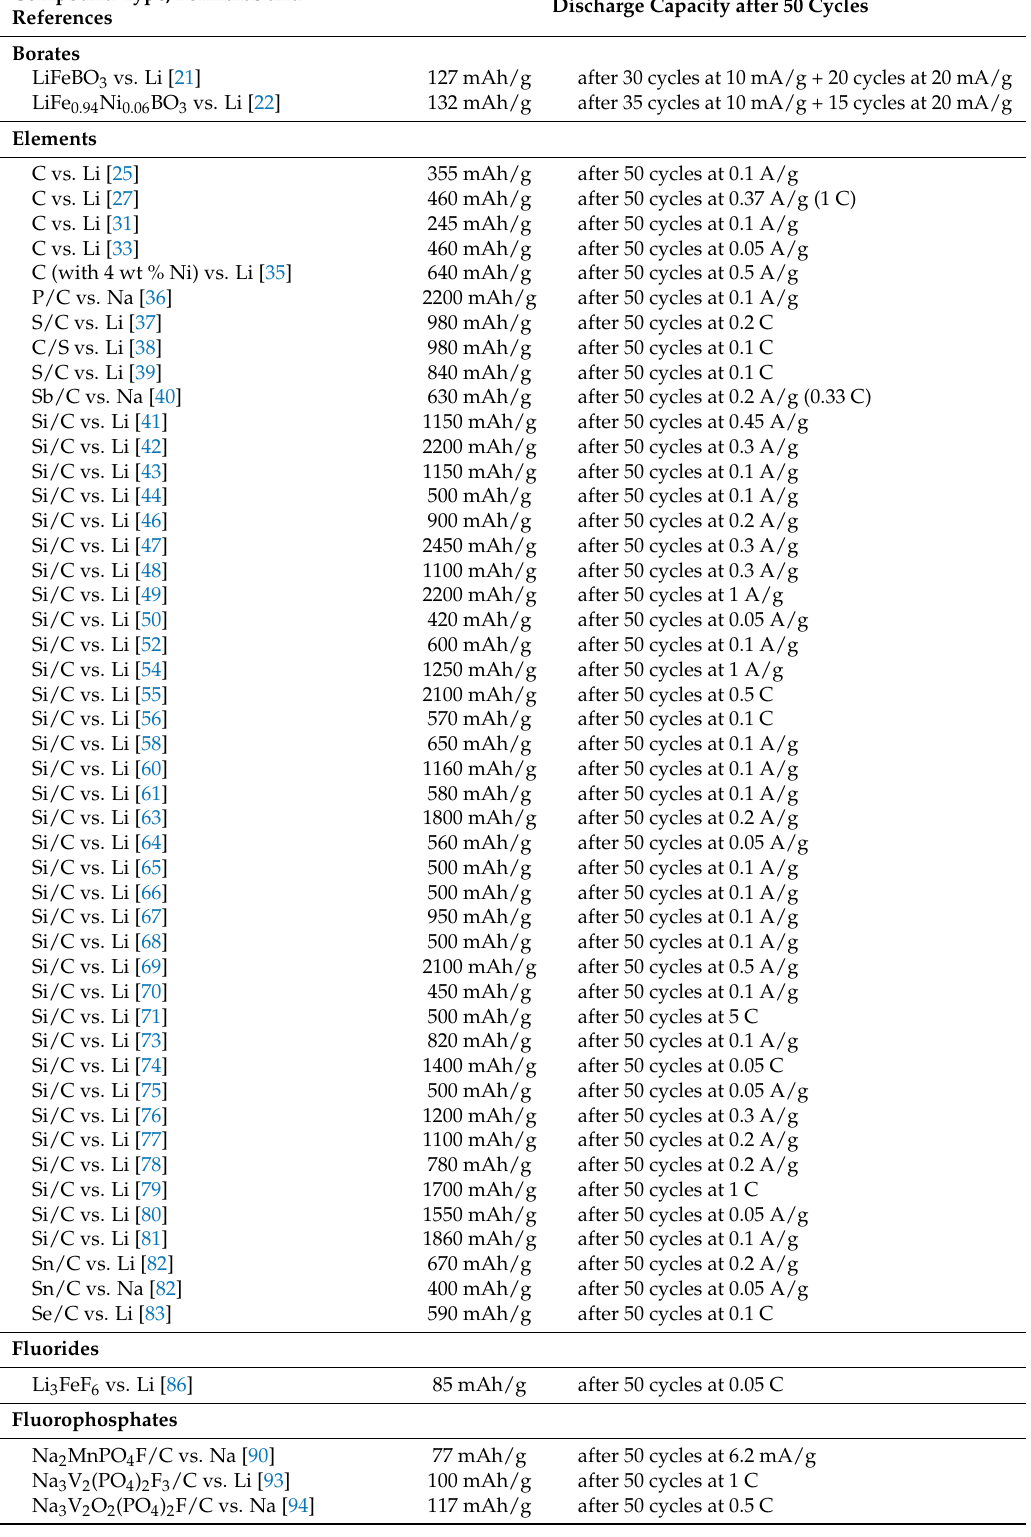
Table A3. Discharge specific capacity (in mAh/g) after 50 cycles at the indicated current density (in A/g or as a C-rate). For counter electrode, see first